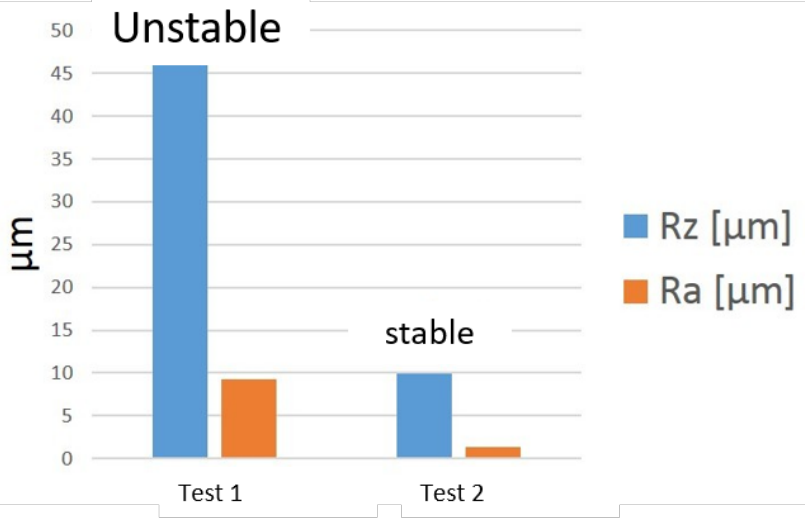
Fig. 8. Roughness tests 1 and